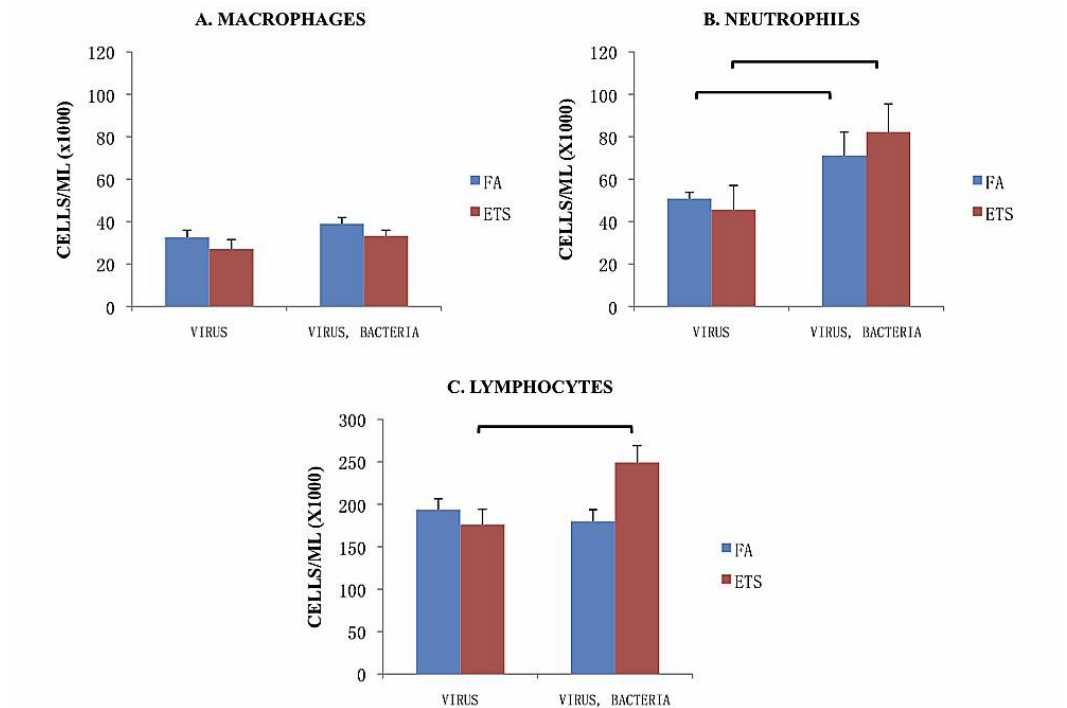
Figure 5. Breakdown of cell types in the BALF. The numbers presented in these graphs represent the cell number/mL found in BALF. Data is presented as the group mean (n = 10) ±SEM. The bracket between designated bars signifies a statistically significant difference between the FA-virus and FA-virus-bacteria and ETS-virus and ETS-virus-bacteria groups ( p < 0.05).